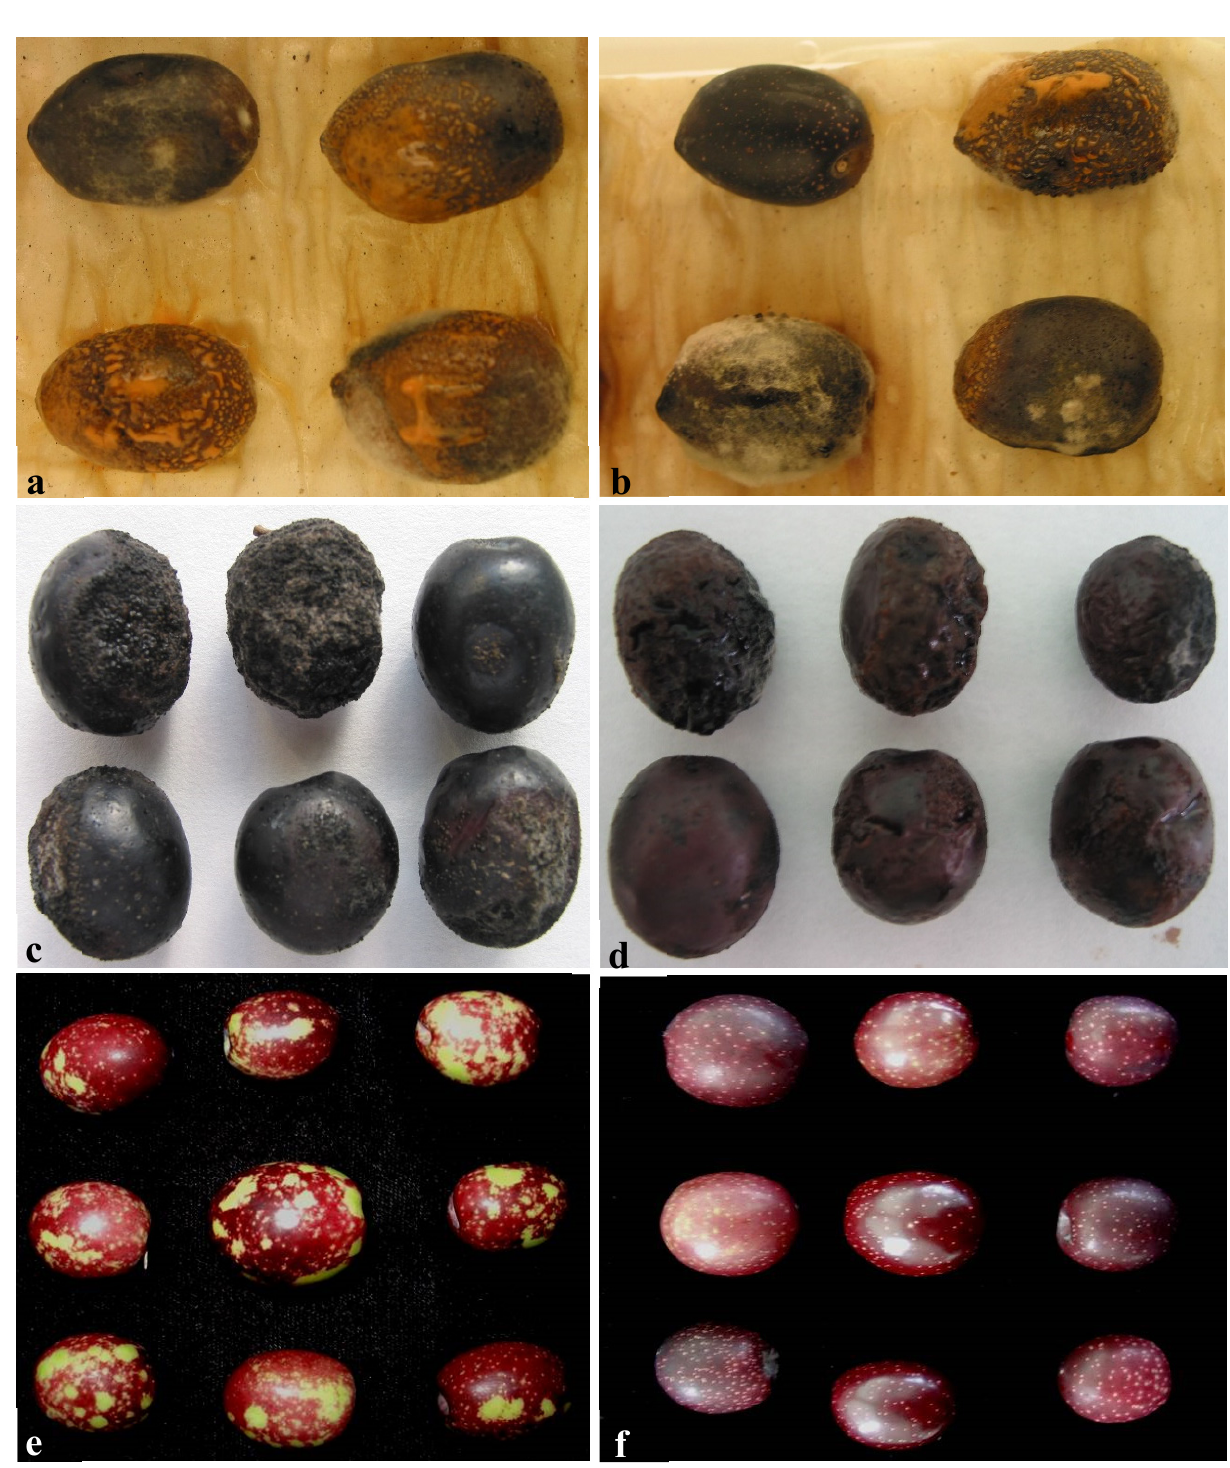
Figure 8. Anthracnose symptoms developed on non-wounded violet (color class 3) olive fruit of cv. Hojiblanca 14 days after inoculation with conidial suspension of the following isolates: ( a ), Colletotrichum nymphaeae from olives (Col-42); ( b ), C. godetiae from olives (Col-57); ( c ), C. karstii from sweet oranges (Col-79); ( d ), C. gloeosporioides from sweet oranges (Col-69); ( e ), C. nymphaeae from strawberries (Col-84) and ( f ), non-inoculated control olive fruit.